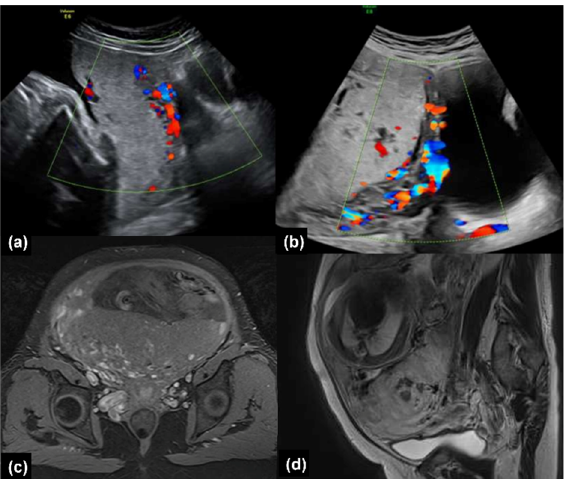
Figure 1. ( a ) Color Doppler ultrasound examination of abnormal placental lacunae and uterovesical hypervascularity (Case 1), and ( b ) abnormal placental lacunae, placenta bulging and uterovesical hypervascularity (Case 2). ( c ) T1-weighted transverse magnetic resonance images (MRI) demon- strating prominent vascularity around the uterus (Case 1). ( d ) T1-weighted sagittal MRI demon- strating low signal intensity area in the placenta (Case